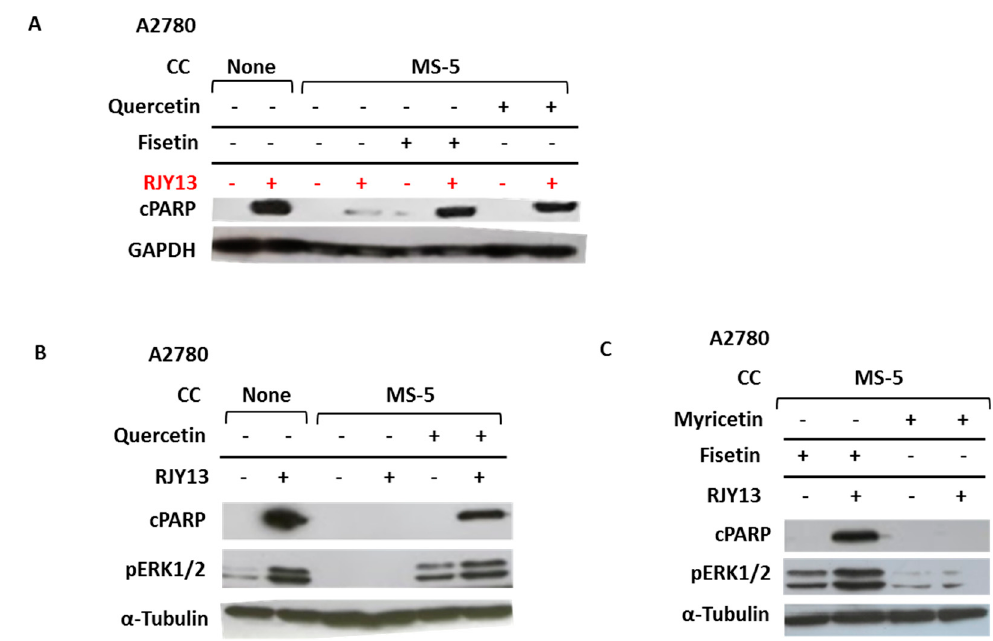
Figure 5. Fisetin and quercetin activate ERK1/2 in co-culture with MS-5 cells and restore OC cell platinum drug sensitivity. OC cells were treated with RJY13 in the presence and absence of MS-5 cells and levels of cleaved PARP (cPARP; A – C ) and phospho-ERK1/2 ( B , C ) were monitored. Fisetin ( A , C ), quercetin ( A , B ), or myricetin ( C ) were added at 10 μ M along with RJY13. α -Tubulin was used as a loading control. CC, co-culture.